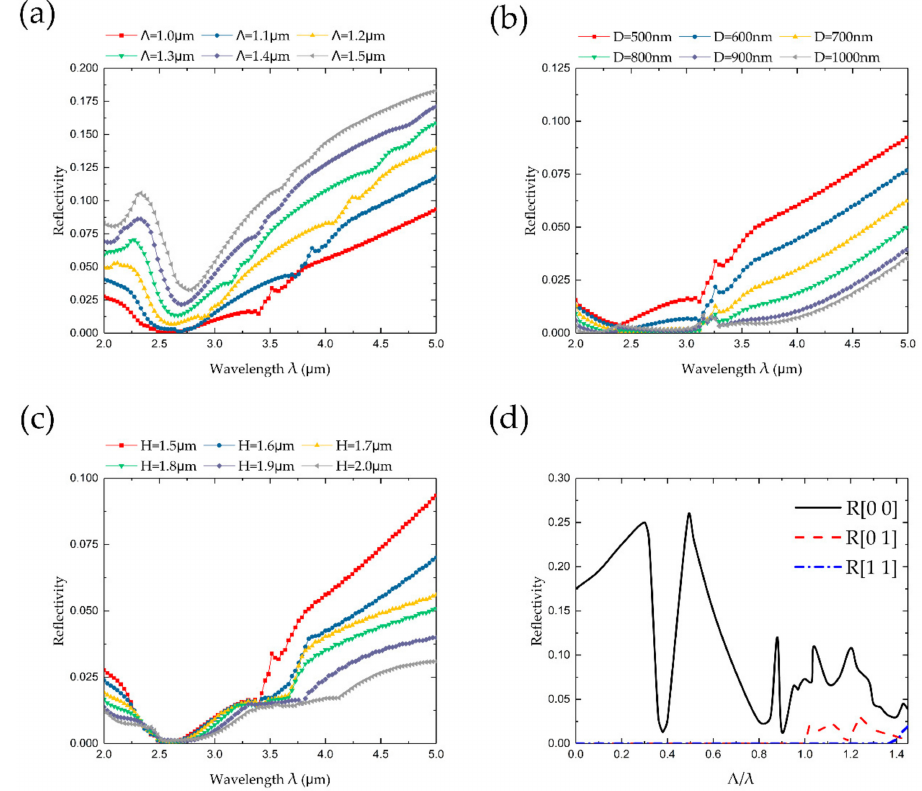
Figure 3. Optimized basic parameters of moth-eye structure with a waist (normal incidence): ( a ) reflectivity of structure array with D = 500 nm, H = 1500 nm, and Λ = 1.0–1.5 µ m; ( b ) reflectivity of structure array with Λ = 1000 nm, H = 1500 nm, and D = 500-1000 nm; ( c ) reflectivity of structure array with Λ = 1000 nm, D = 500 nm, and H = 1.5–2.0 µ m; ( d ) reflectivity of different